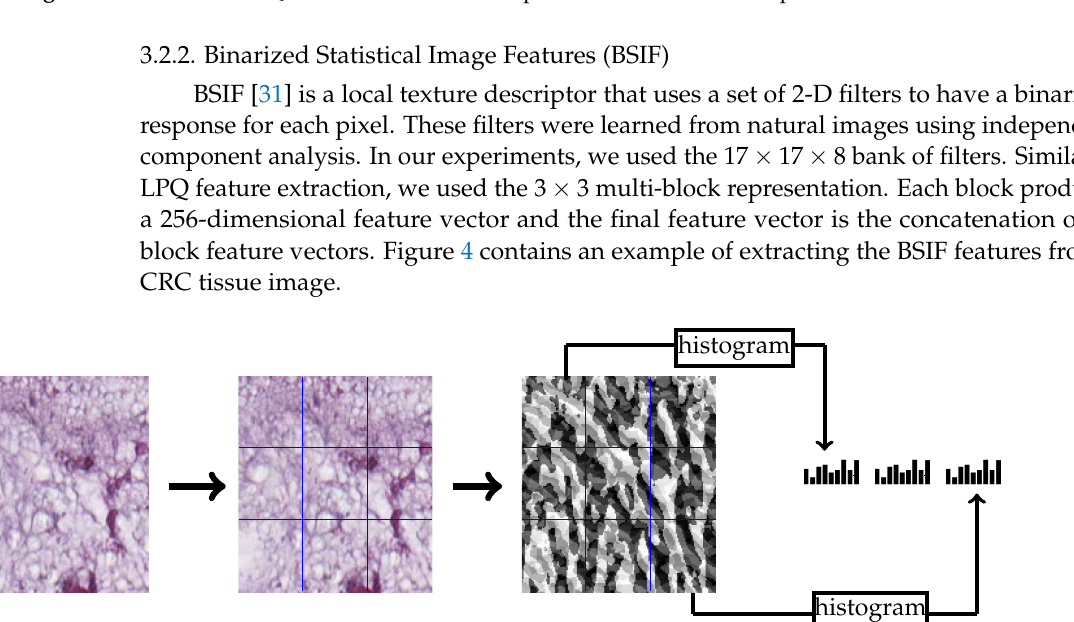
Figure 3. Multi-block LPQ feature extraction example of 3 × 3 multi-block representation.